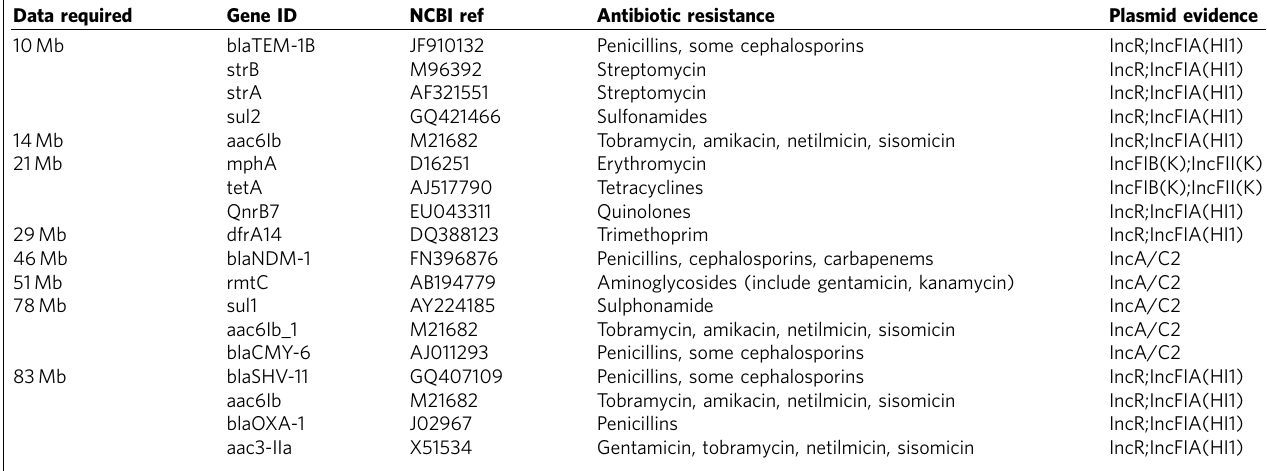
Table 2 | Timeline of determining plasmid-encoded antibiotic resistance genes. Data